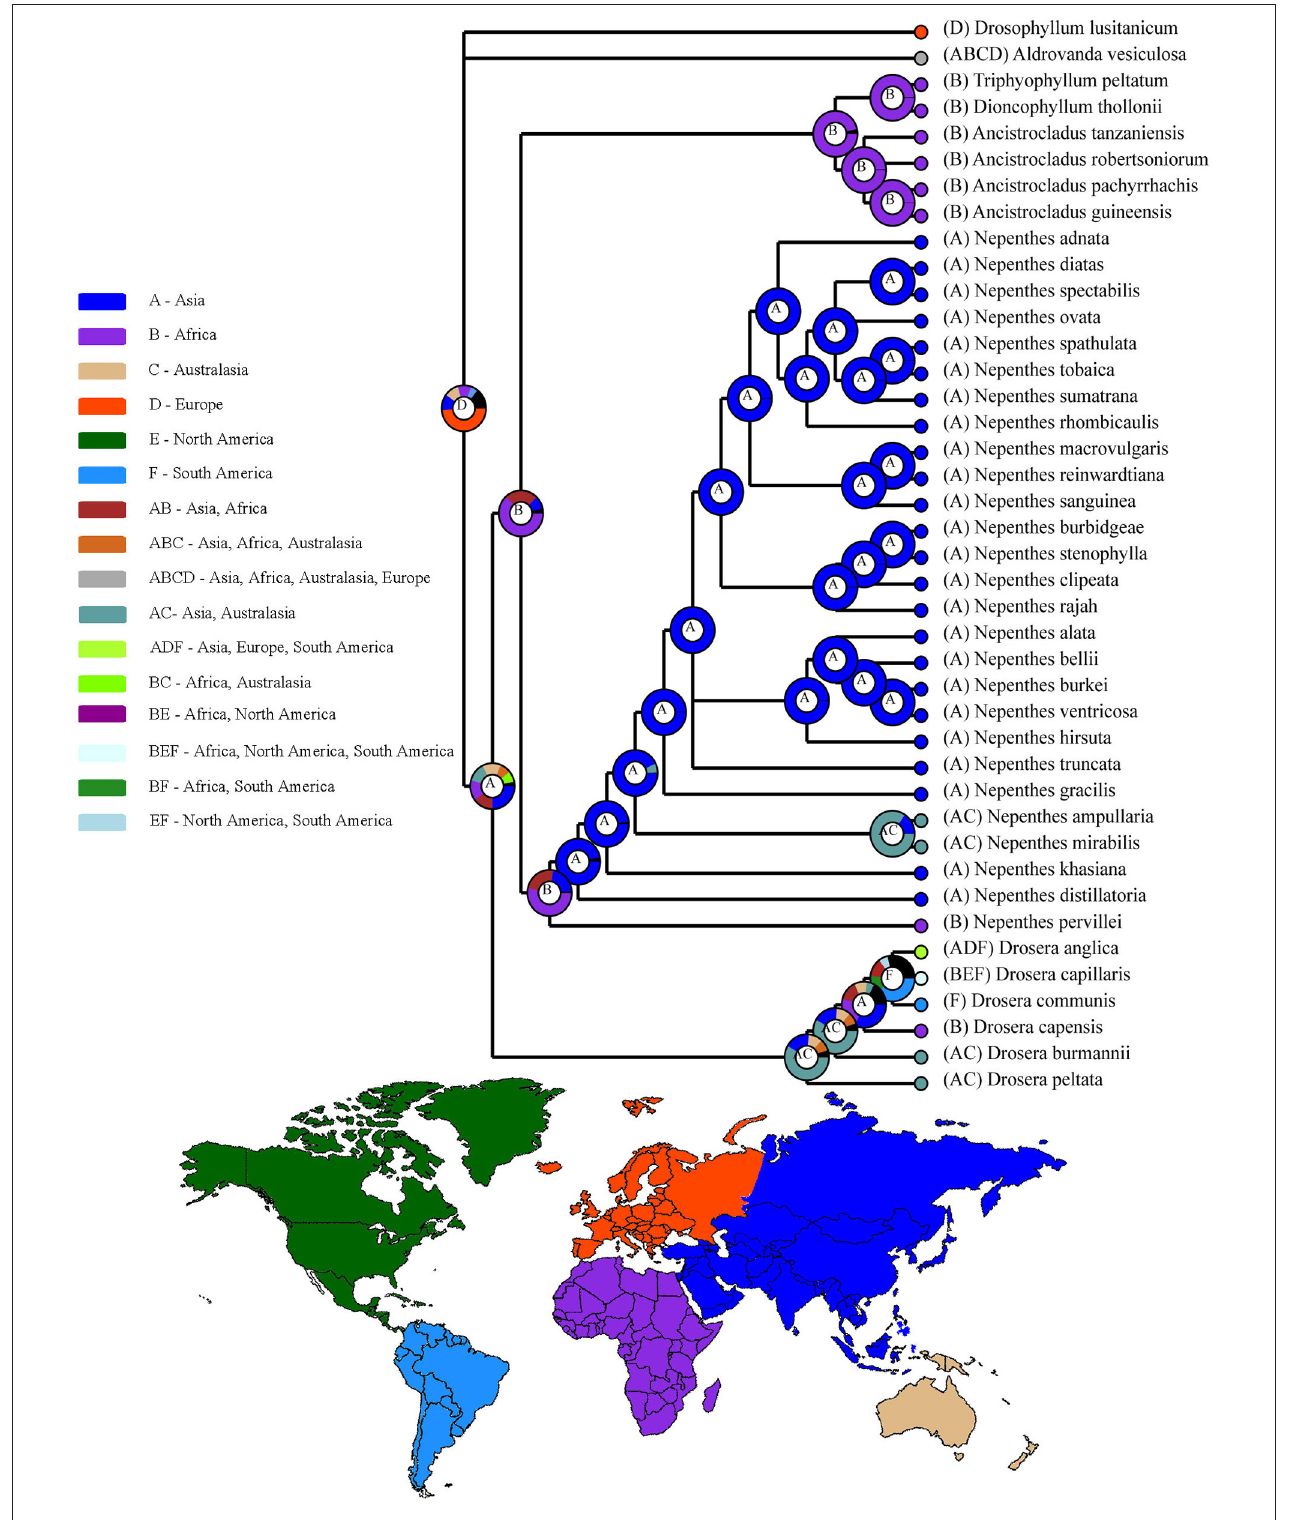
FIGURE 5 | Ancestral area reconstruction along with distribution world map of species belonging to Nepenthaceae, Droseraceae, Drosophyllaceae, Dioncophyllaceae, and Ancistrocladaceae using RASP (S-DIVA and BBM). Alternative ancestral ranges of nodes (with frequency of occurrence) are shown in pie chart form. Bootstrap support values/Bayesian credibility values (PP) (50 % and higher) are indicated near the pie chart in the Bayesian tree. Color key to possible ancestral ranges at different nodes represent other ancestral ranges. Biogeographical regions: A, Asia; B, Africa; C, Australasia; D, Europe; E, North America; F, South America; AB, Asia-Africa; ABC, Asia-Africa-Australasia; ABCD, Asia-Africa-Australasia-Europe.